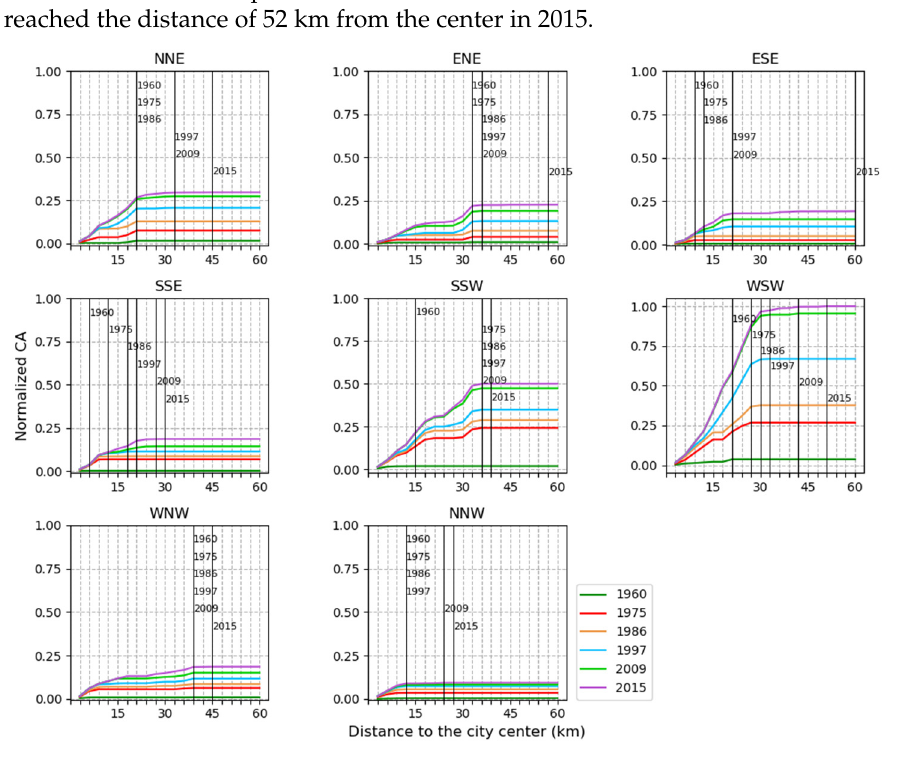
Figure 5. The number of urban patches in different directions and within concentric rings from 1960 to 2015. The x-axis represents the distances to the city center. The y-axis represents the normalized value of the metric. The black vertical line represents the distance where the metric value became stable for each year.